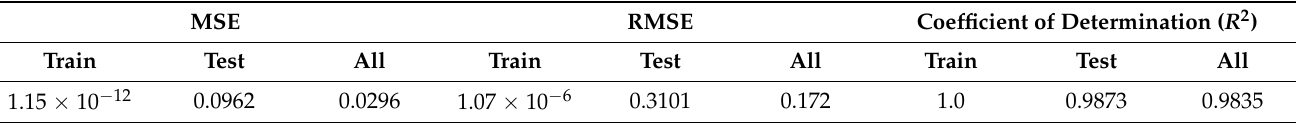
Table 2. Numerical assessment of the fuzzy